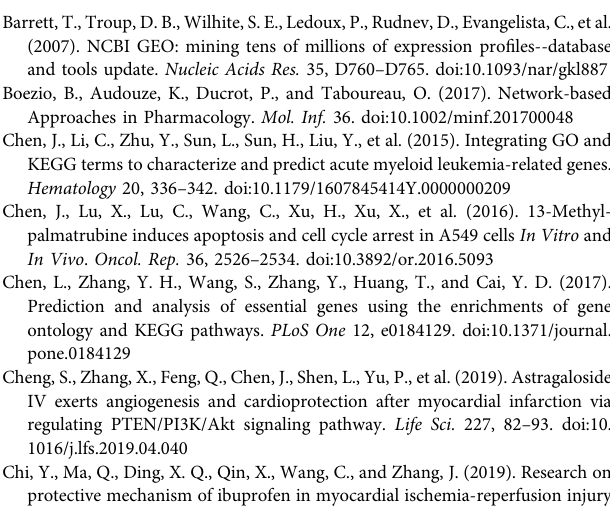
Supplementary Figure S1 | Component-target network. There were 60 bioactive components and 431 potential targets of RC. The orange nodes represent the potential active ingredients, and the violet nodes represent the core targets. Supplementary Figure S2 | Molecular docking diagram of Akt with berberine, coptisine, palmatine, and quercetin. Structure diagram of Akt docked (A) berberine, (B) coptisine, (C) palmatine, and (D) quercetin. Yellow lines represent hydrogen bond. (E) The binding energy for berberine, coptisine, palmatine, and quercetin docked into the Akt crystal